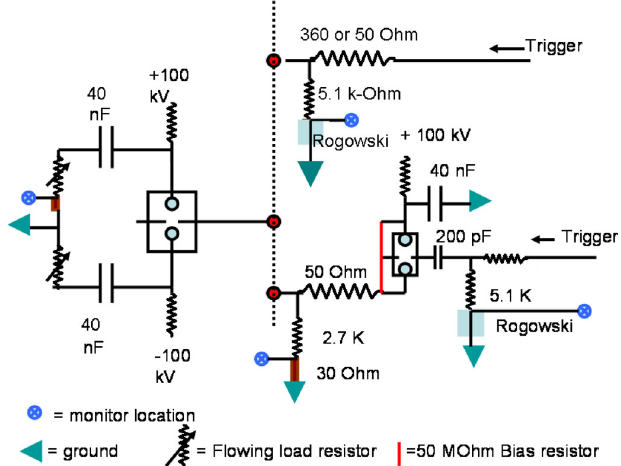
FIG. 28. (Color) Schematic of the two trigger circuits used in these experiments. The LTD brick is on the left. The original trigger system consisting of the L3 trigger generator with a 360 or 50 Ohm series resistor is on the upper right. The final trigger system that has an extra stage of power amplification is at the lower